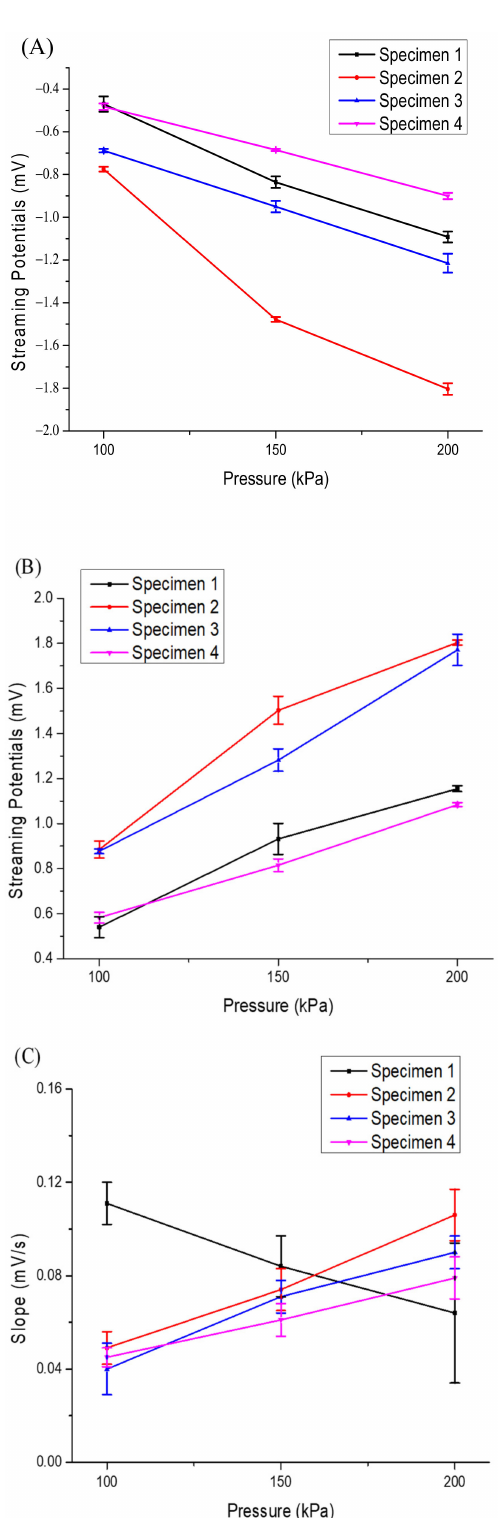
Figure 3. ( A ) Negative pulse amplitudes corresponding to the loading edges. ( B ) Pulse amplitudes corresponding to the unloading edges. ( C ) Slopes under the pressure holding